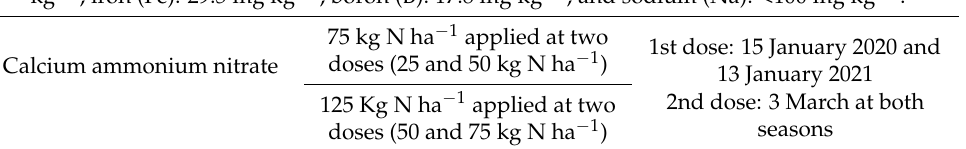
Table 1. Description of organic and inorganic fertilization treatments. Fertilizers